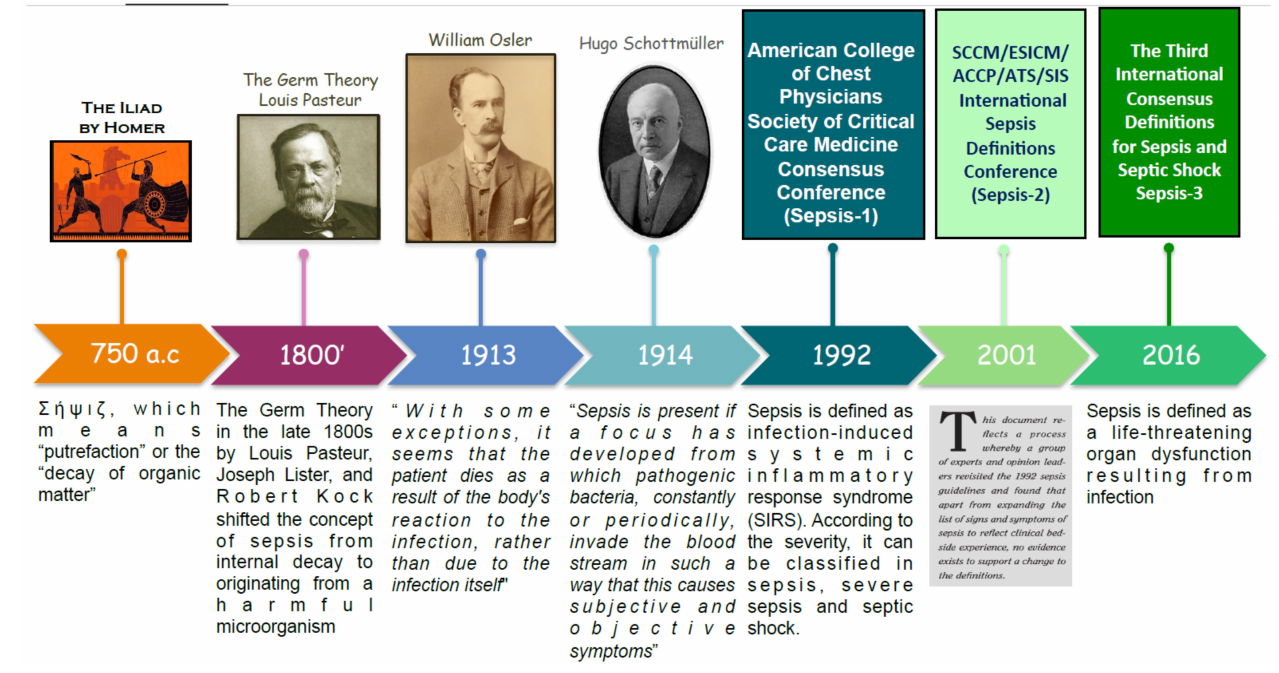
Figure 1. Timeline of the evolution of the sepsis definition. Sepsis is a highly heterogeneous disease both in terms of etiology and pathogene- sis [15]. Gram-negative bacteria are the most frequent pathogen causing sepsis,